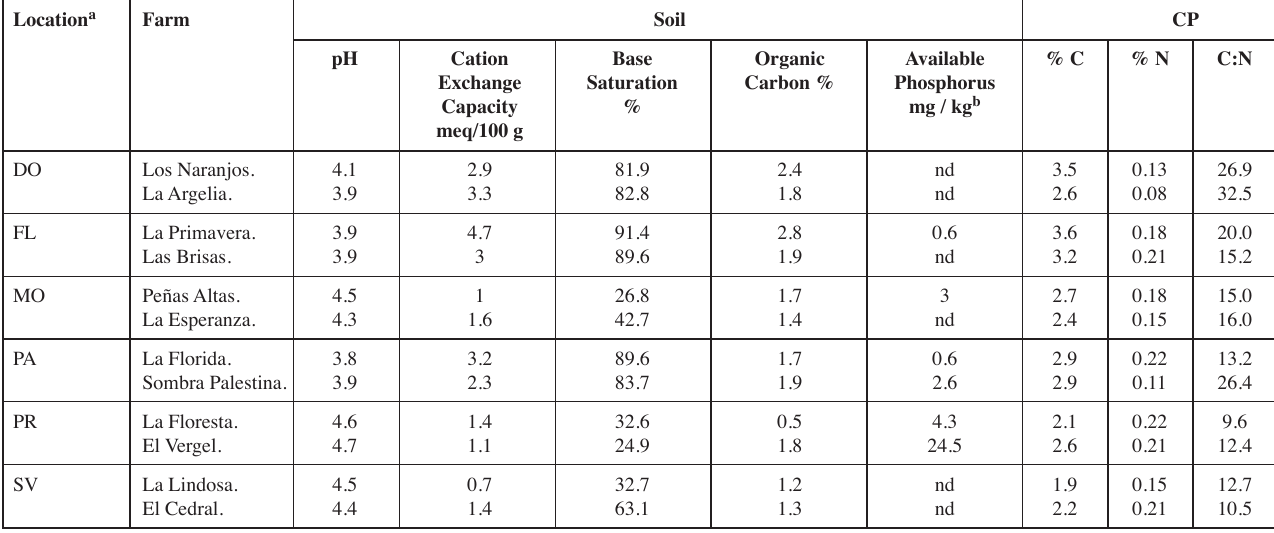
Tab. 1: Chemical properties of soils and decomposing coffee pulp (CP) in six locations of Caquetá, Colombia. Location a Farm